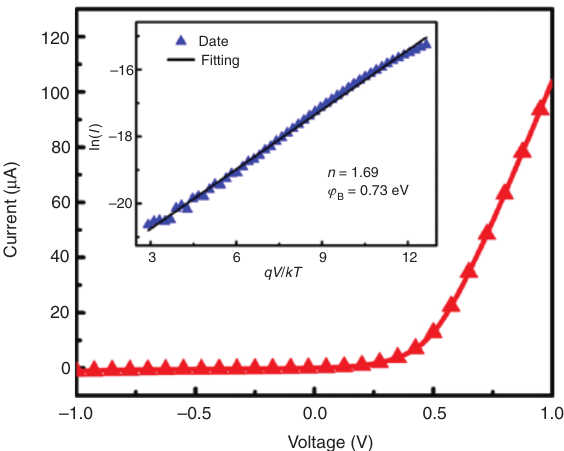
Figure 3: I - V characteristics of PD measured at room temperature under dark. (Inset) ln( I ) vs. qV / kT used to estimate n and φ Ga O 2 3